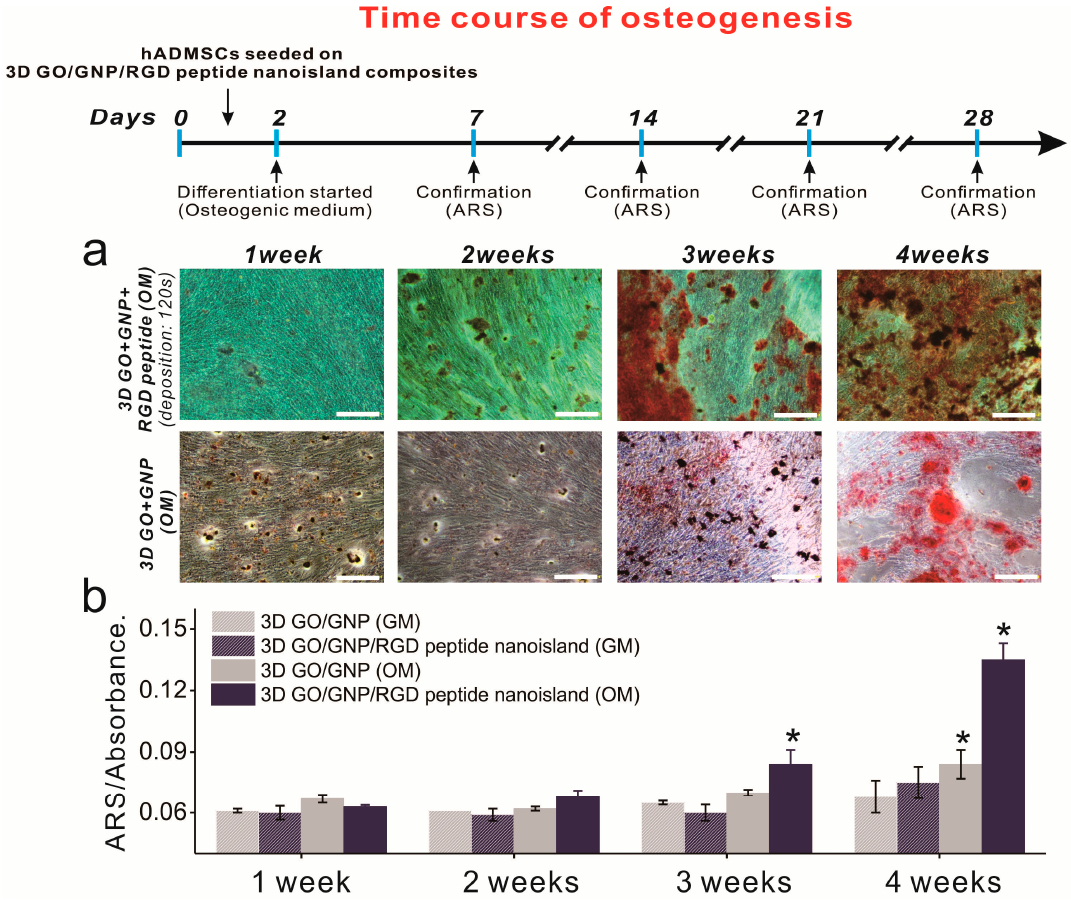
Figure 6. Time course of osteogenesis with and without RGD–MAP–C peptides. ( a ) ADSC differentiation was monitored every 7 d. Scale bars = 200 µ m; ( b ) ARS absorbance changes in the presence of gold and different media. * Student’s t -test, p < 0.05, n = 3.